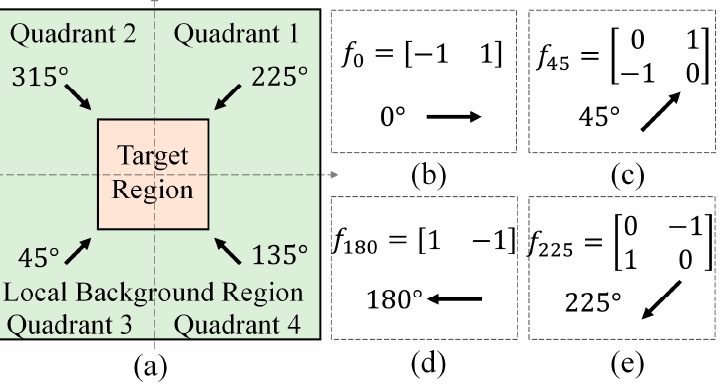
Figure 6. ( a ) Illustration of index distance calculation for quadrant 1 in different situations; ( b ) ex- ample of the four quadrants having the same maximum gradient directions; ( c ) example of domi- nant direction of two quadrants having a negative gradient score.